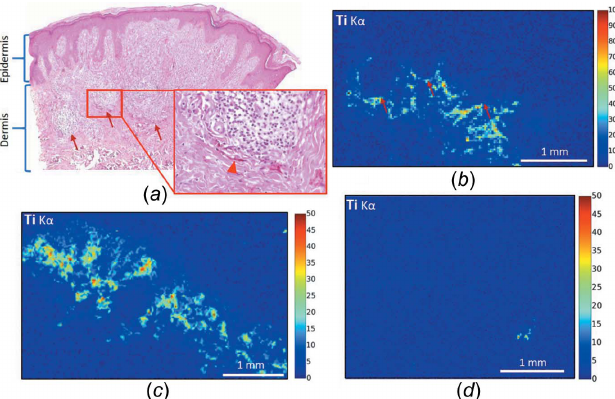
Figure 6 Optical microscopy and XRF maps, spatial distribution of Ti. ( a ) Patient 5, optical microscopy showing red ink (higher magnification HES (cid:4) 400, arrowheads) in the mid-dermis, at the periphery of a diffused inflammatory infiltrate (HES (cid:4) 40, arrows: lower limits of the inflamma- tory infiltrate). ( b ) Patient 5, XRF map, showing Ti on the periphery of the inflammatory infiltrate (arrows: lower limits of the inflammatory infiltrate). ( c ) Patient 6. In these two samples, Ti is co-located with the pigment. ( d ) Patient 2, Ti is located around a hair follicle bulb.